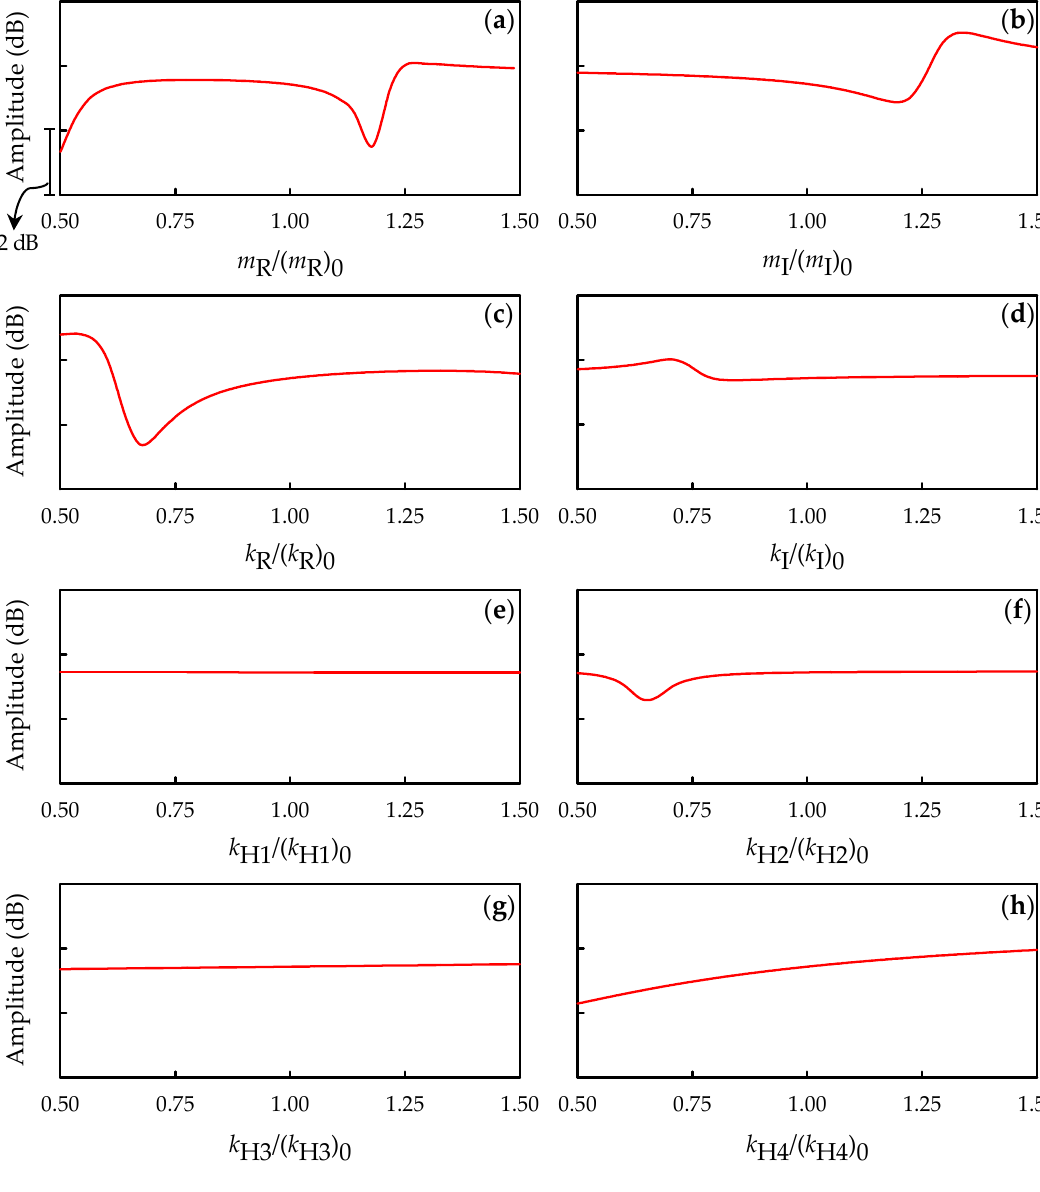
Figure 19. Idle vibration levels for the variations of the eight design variables: ( a ) radiator mass; ( b ) intercooler mass; ( c ) rubber bushing stiffness of the radiator; ( d ) rubber bushing stiffness of the intercooler; ( e ) upper hose stiffness of the radiator; ( f ) lower hose stiffness of the radiator; ( g ) upper hose stiffness of the intercooler; and ( h ) lower hose stiffness of the intercooler.